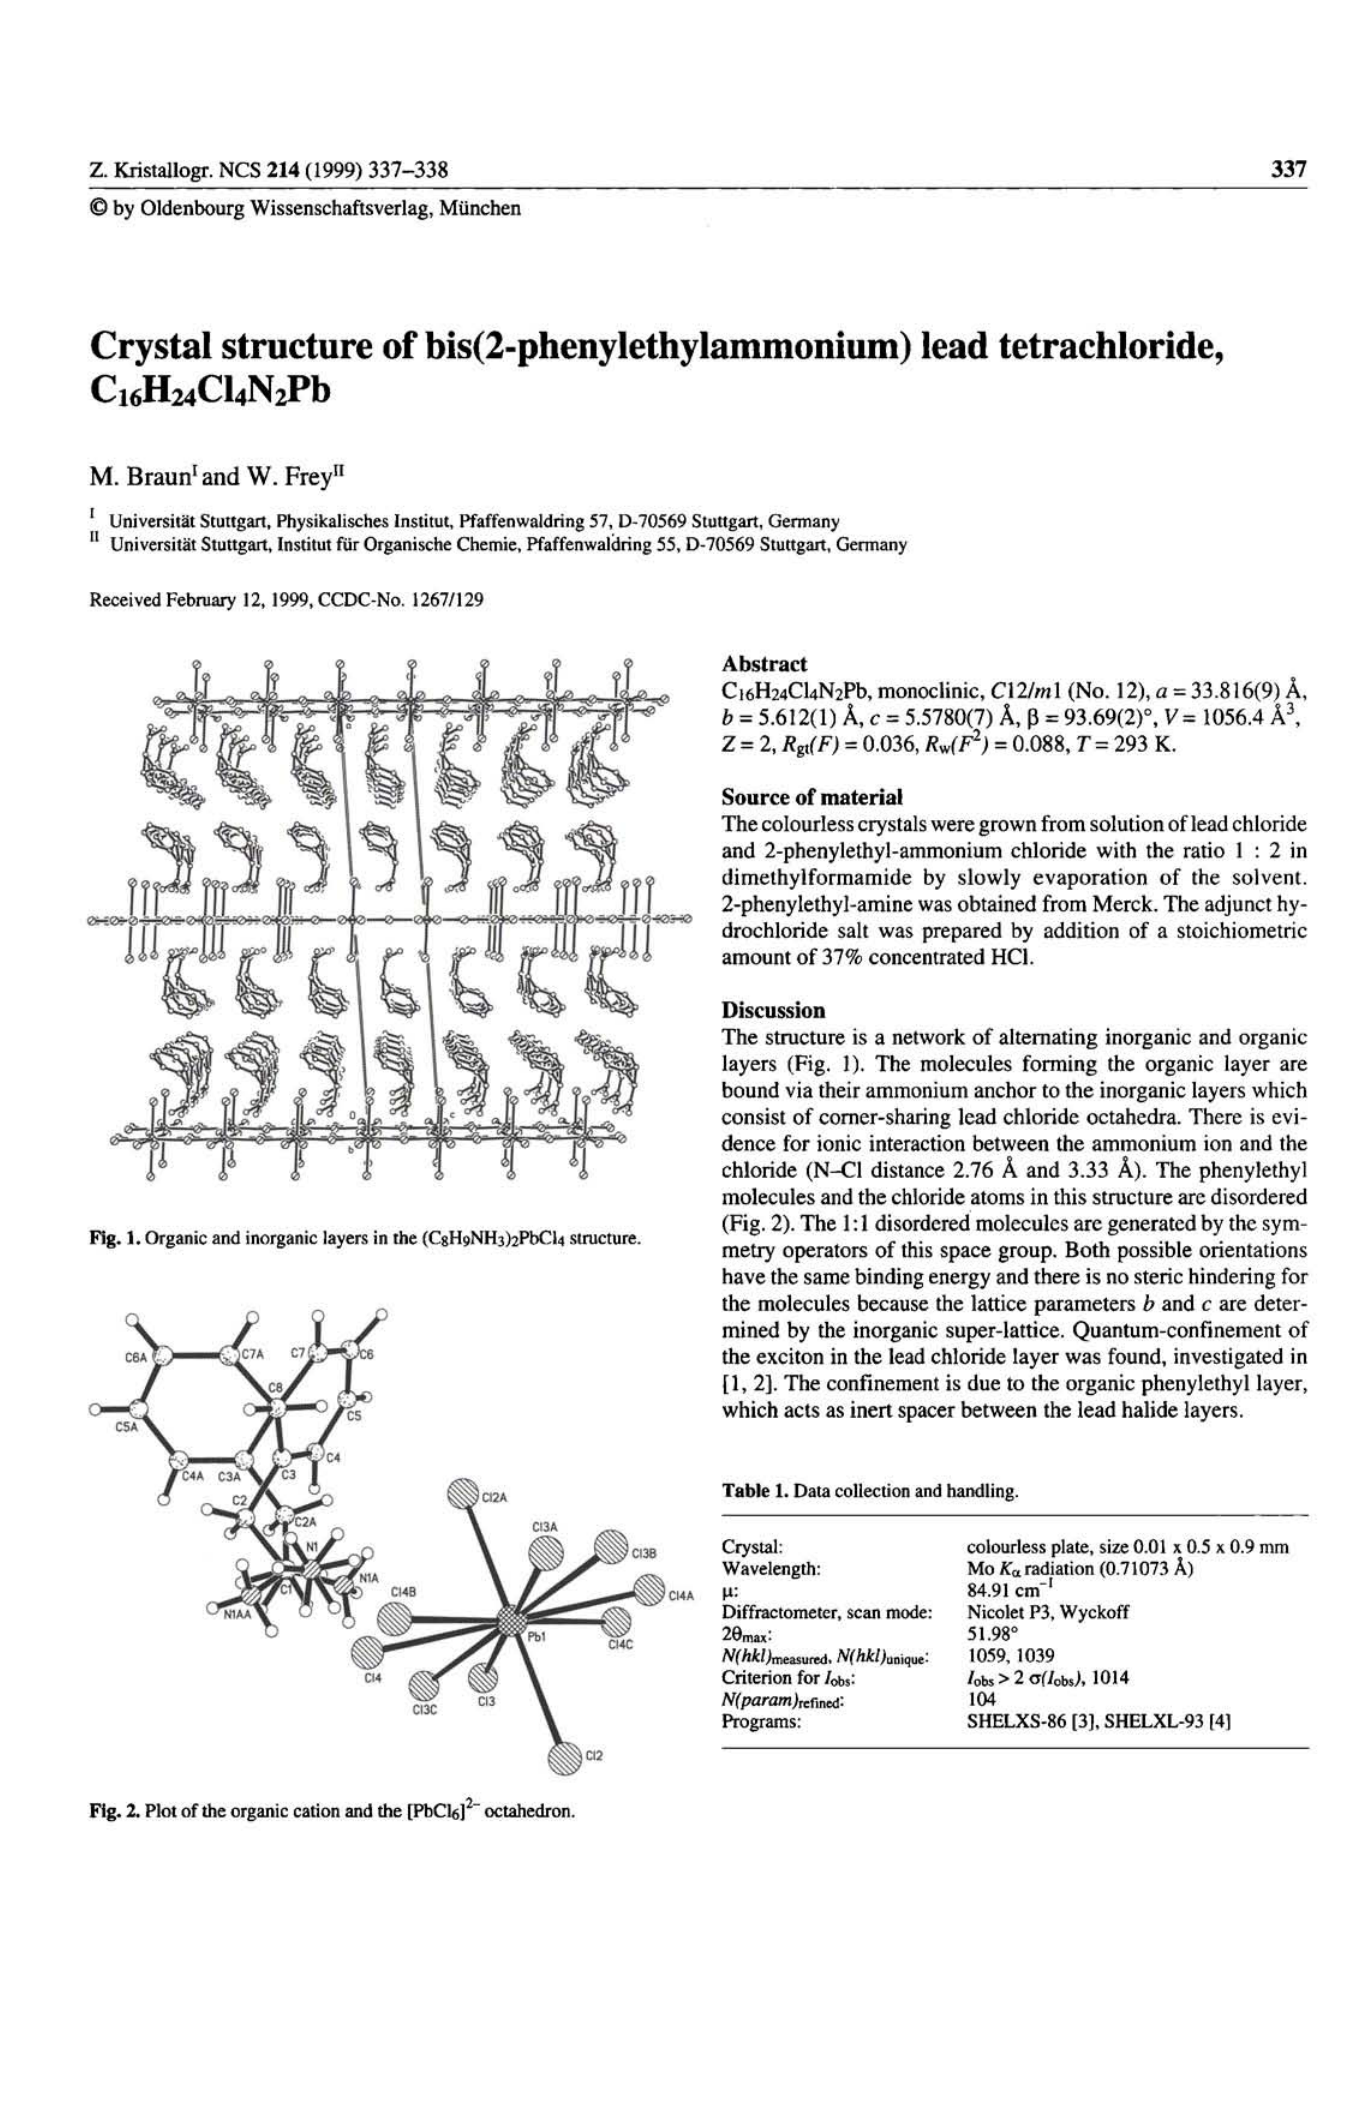
Table 1. Data collection and handling.